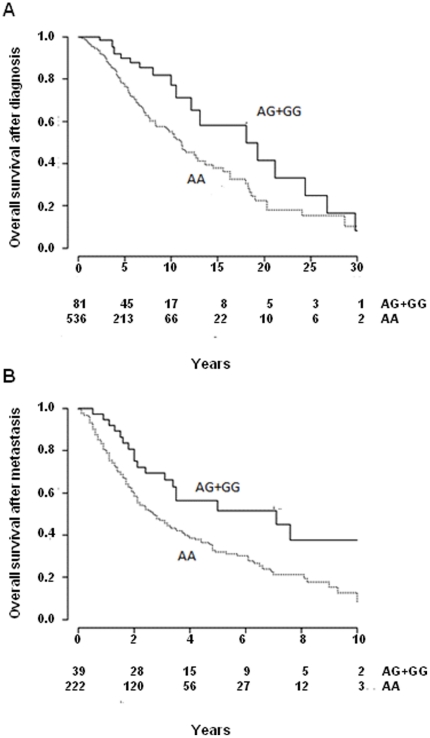
Overall survival (OS) and survival after metastasis (SFM) in German cutaneous melanoma patients according to theTLR4-rs4986790 (D299G) genotype.The Kaplan-Meier curves differentiate between carriers of the minor allele (AG+GG) and homozygote genotypes (AA) for (A) overall survival, log-rank P = 0.005 and (B) survival following the first metastasis, log-rank P = 0.01. Number of patients, both carriers and non-carriers, is given below the x-axis.